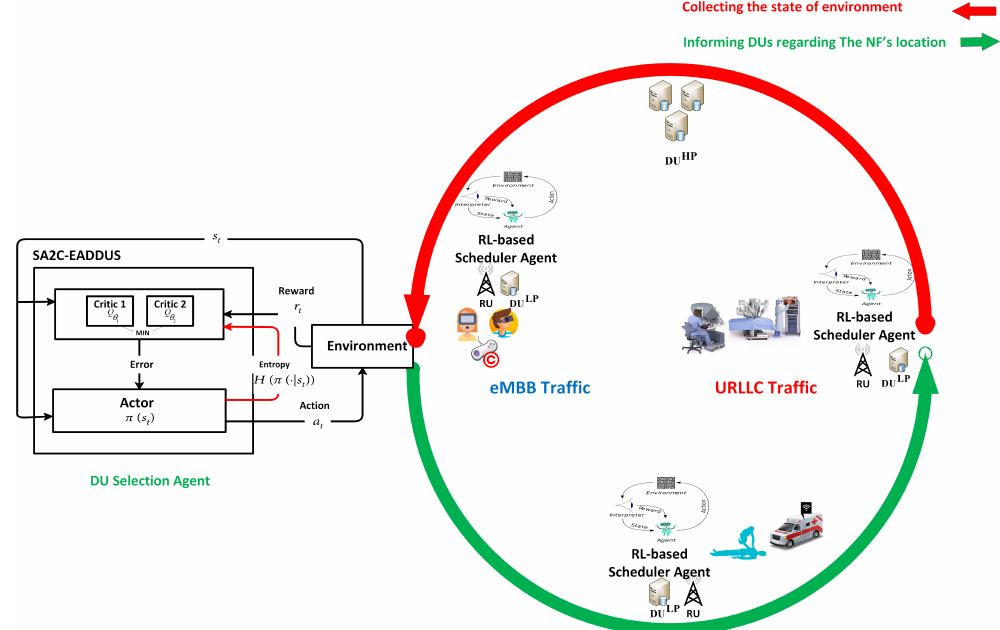
Figure 1. The overall architecture of the proposed model. Agents are located at DUs and interact with the DU selection algorithm by sending some feedback during each time interval (the red arrow). Then the DU selection scheme informs agents (the green arrow) regarding the location of NF during the next time interval based on the types of packets (URLLC or eMBB), available processing capacity, scheduling delay, and propagation delay among DUs to minimize the overall energy consumption in the